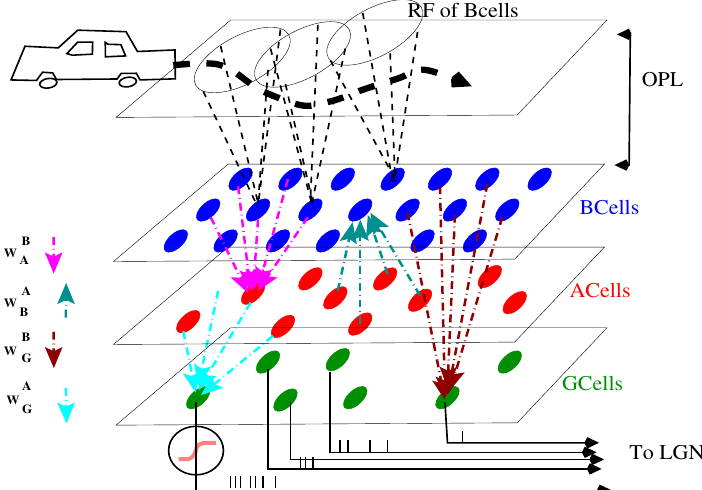
Figure 1. Structure of the retina model introduced in Section 2.1. A moving object (here, presumably, a car) moves along a trajectory (dashed black line). Its image is projected by the eye optics to the upper retina layers (Photoreceptors and H cells) and stimulates them. In the model, this corresponds to the convolution of the stimulus with the Receptive Field (RF) of B cells. This provides to B cells what we call the “OPL” input to B cells. B cells (blue points) are connected to A cells (red points) via excitatory synapses (pink arrows, denoted W B ) and to RG cells (green points) via excitatory synapses (brown A arrows, denoted W B ). A cells are connected to B cells via inhibitory synapses (green arrows, denoted G W A ) and to RG cells via inhibitory synapses (cyan arrows, denoted W A ). The voltage of RG cells is sent B G through a nonlinearity (pink curve in the black circle) so as to produce spike trains conveyed to the